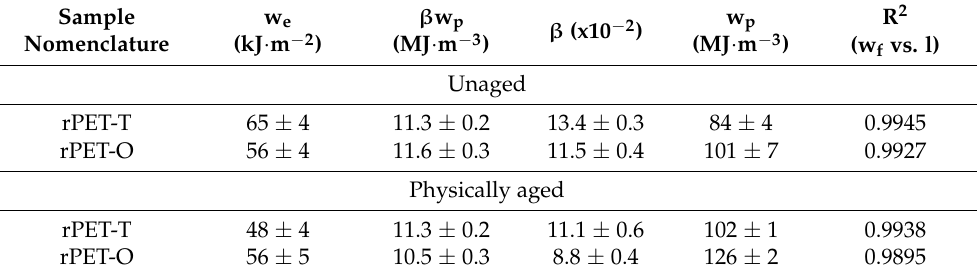
Table 5. The fracture parameters of rPET-T and rPET-O materials at 10 mm · min − 1 .